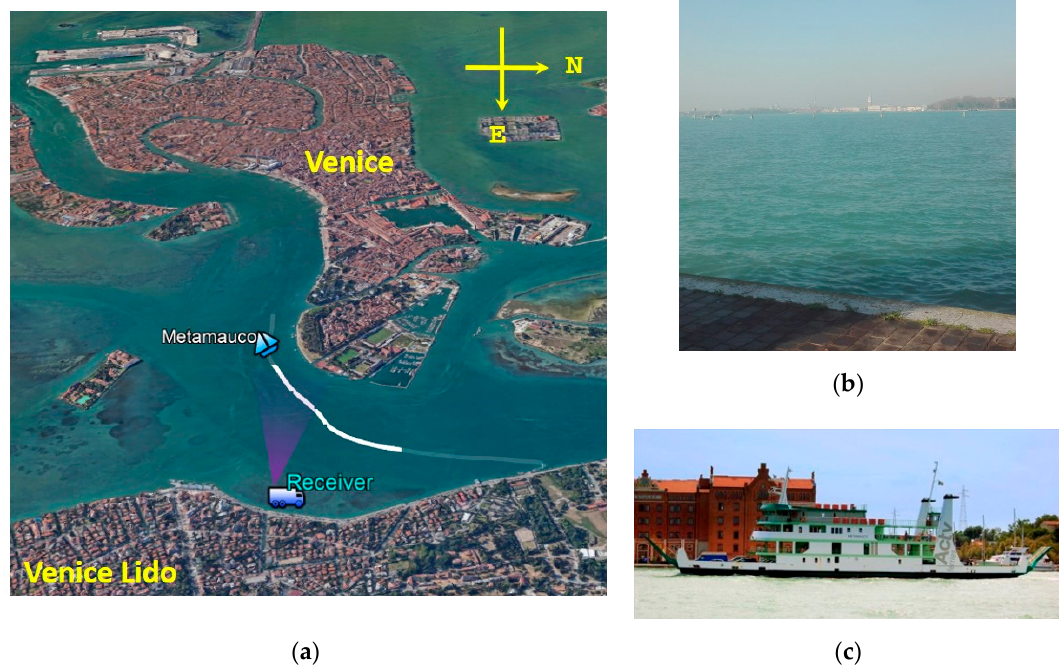
Figure 8. Venice lagoon: ( a ) acquisition geometry; ( b ) optical photograph of the surveyed area; and ( c ) Metamauco (ro-ro ferry).